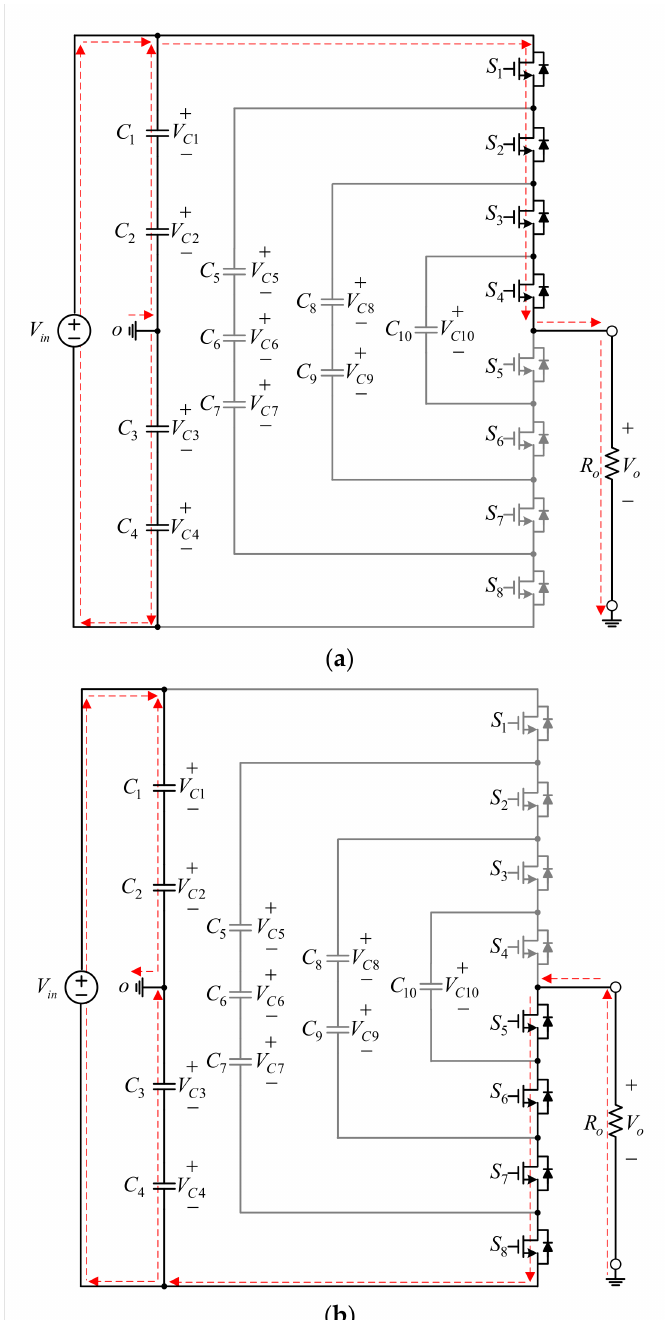
Figure 8. ( a ) Current flow direction of 0.5 V in voltage output; ( b ) current flow direction of − 0.5 V in voltage